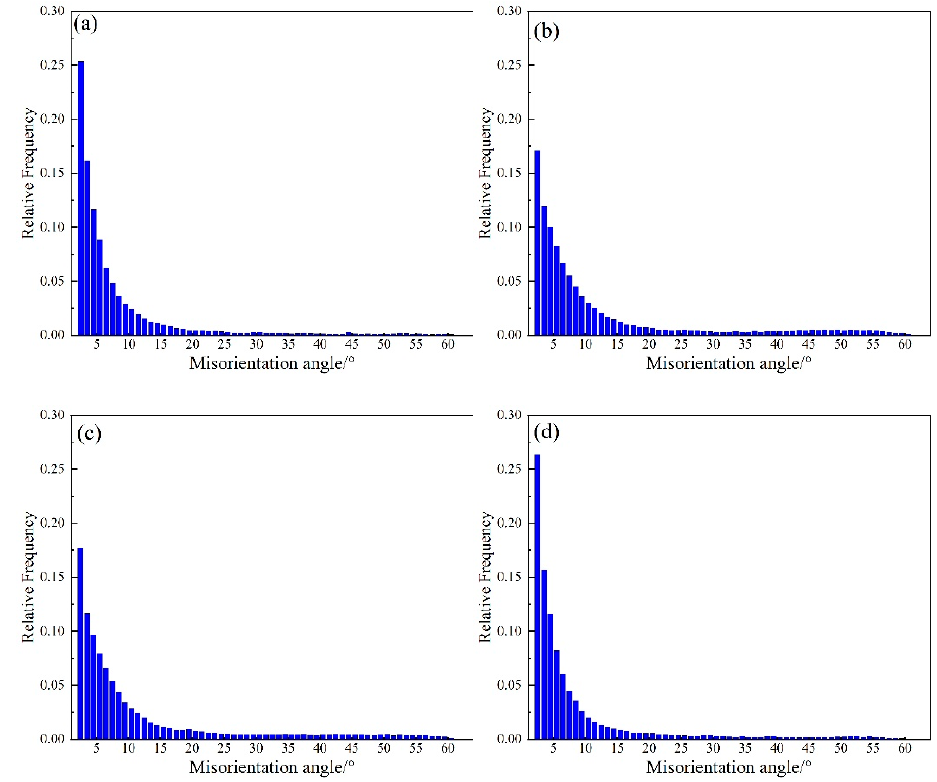
Figure 15. Misorientation angle distribution under different rolling parameters ( a ) 800 °C—88%, ( b ) 800 °C—78%, ( c ) 800 °C—67%, ( d ) 700 °C—78%. ( b ) 800 ◦ C—78%, ( c ) 800 ◦ C—67%, ( d ) 700 ◦